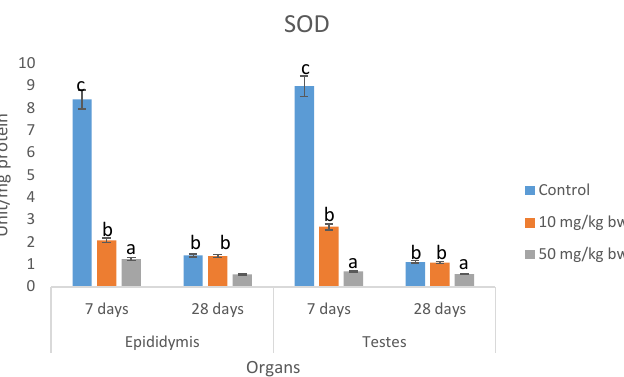
Figure 5. Effects of sub-dermal administration of Ag-NPs on SOD activities in the testis and epididymis of rats. Each bar represent mean ± standard deviation of triplicate determination. Bars with different superscript alphabet are significantly different ( p < 0.05). The high significant levels of the parameters were in the order of a < b < c. Data with superscript alphabet “a” are significantly lower than data with superscript alphabet “b” while data with superscript “b” are lower than data with superscript alphabet “c” at p < 0.05.